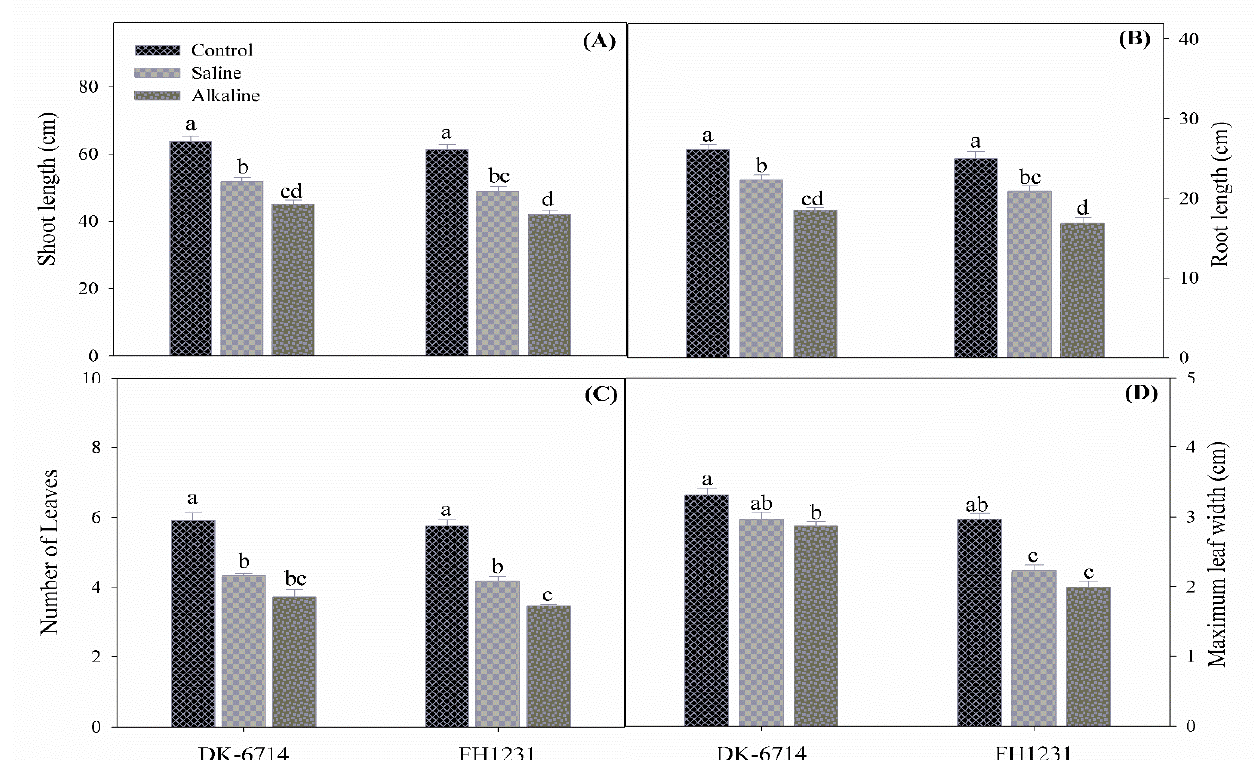
Figure 2. Effect of salinity and alkalinity stress on ( A ) shoot length, ( B ) root length, ( C ) number of leaves per seedling, and ( D ) maximum leaf width of 20-day-old maize seedlings of two hybrids (DK-6714 and FH-1231). The bars represent the standard error (SE) of the four replicates. Similar small letters above bars represent nonsignificant (ns) differences among treatments ( p ≤ 0.05).